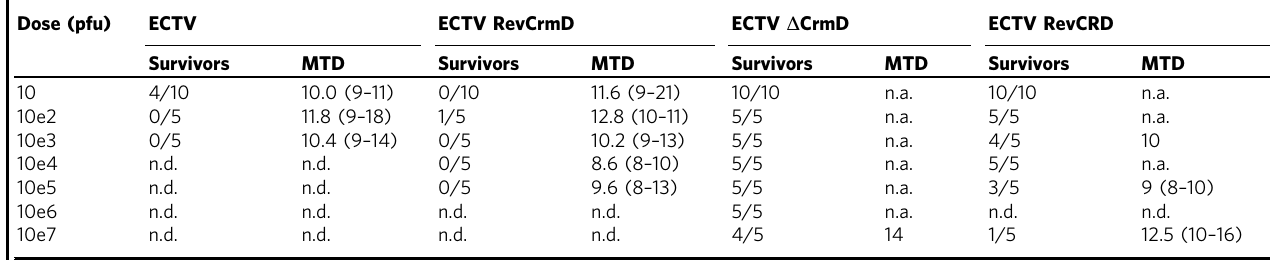
Table 1 Mortality rate determination of CrmD recombinant ECTVs in susceptible BALB/c mice Dose